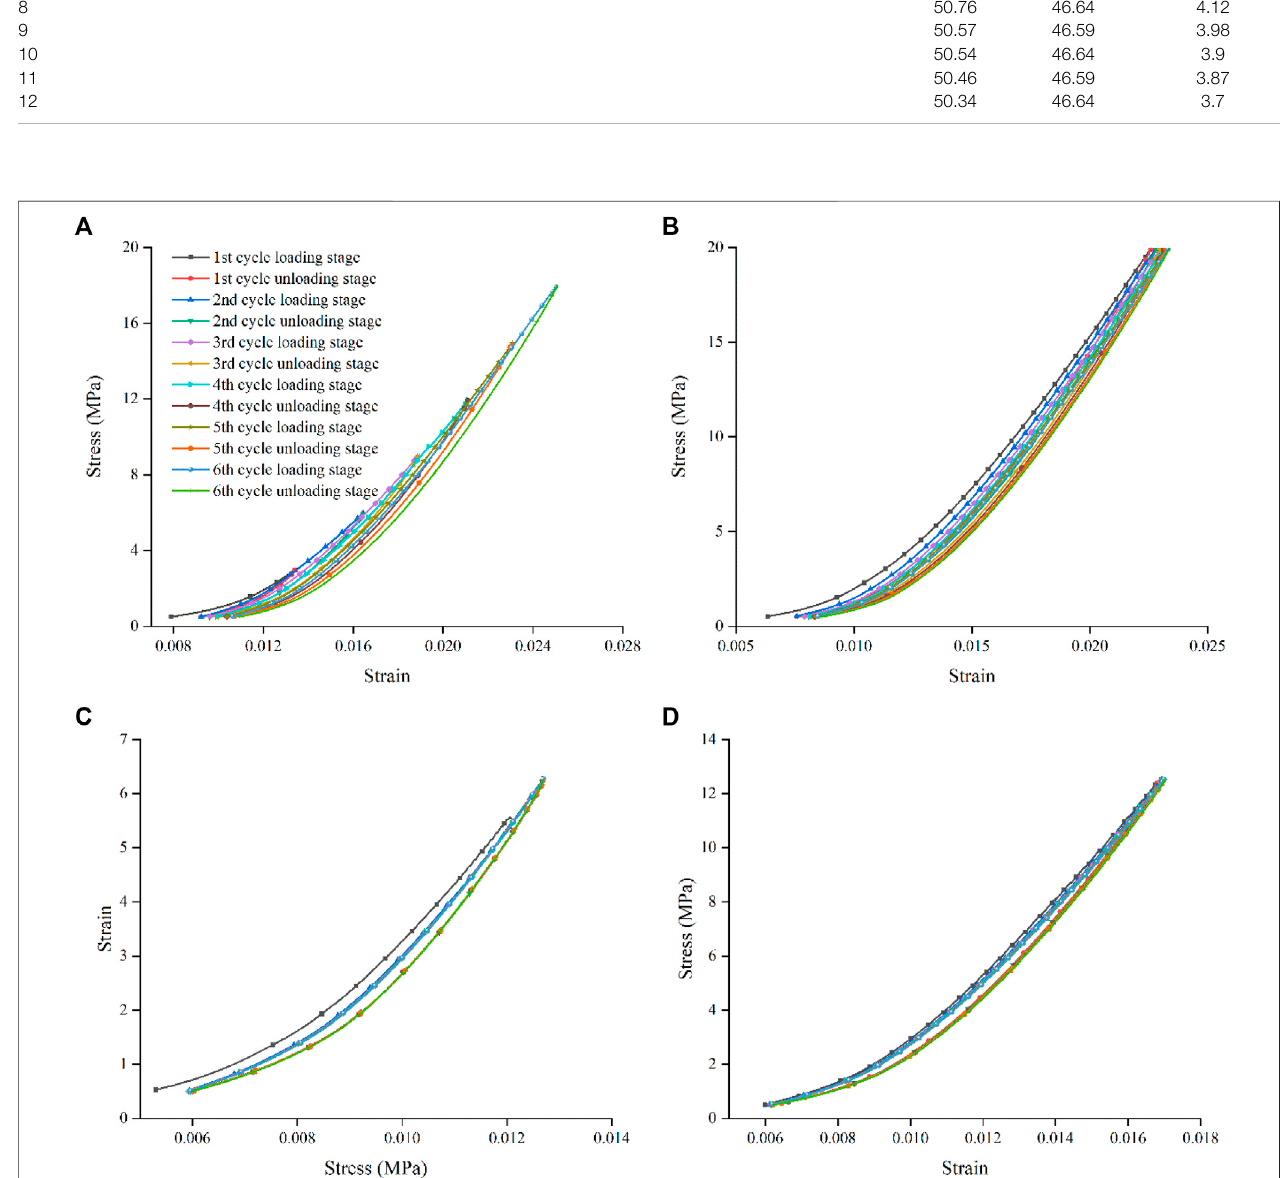
Frontiers in Earth Science |